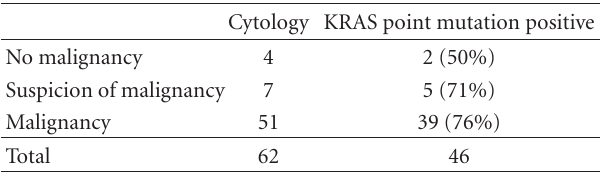
Table 1: Relationship between cytopathologic evaluation and KRAS point mutation in specimens of pancreatic cancer (62 cases) obtained by EUS-FXA; citation from [7].